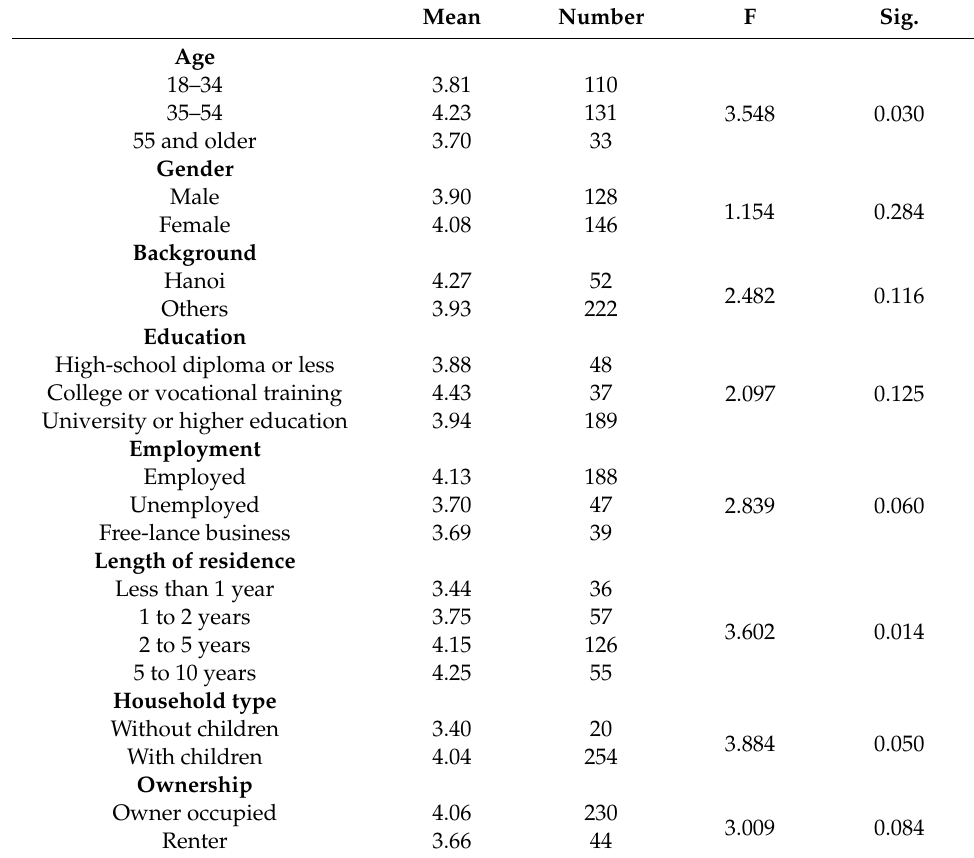
Table 5. The relationships between personal characteristics and the number of social interactions. Mean Number F